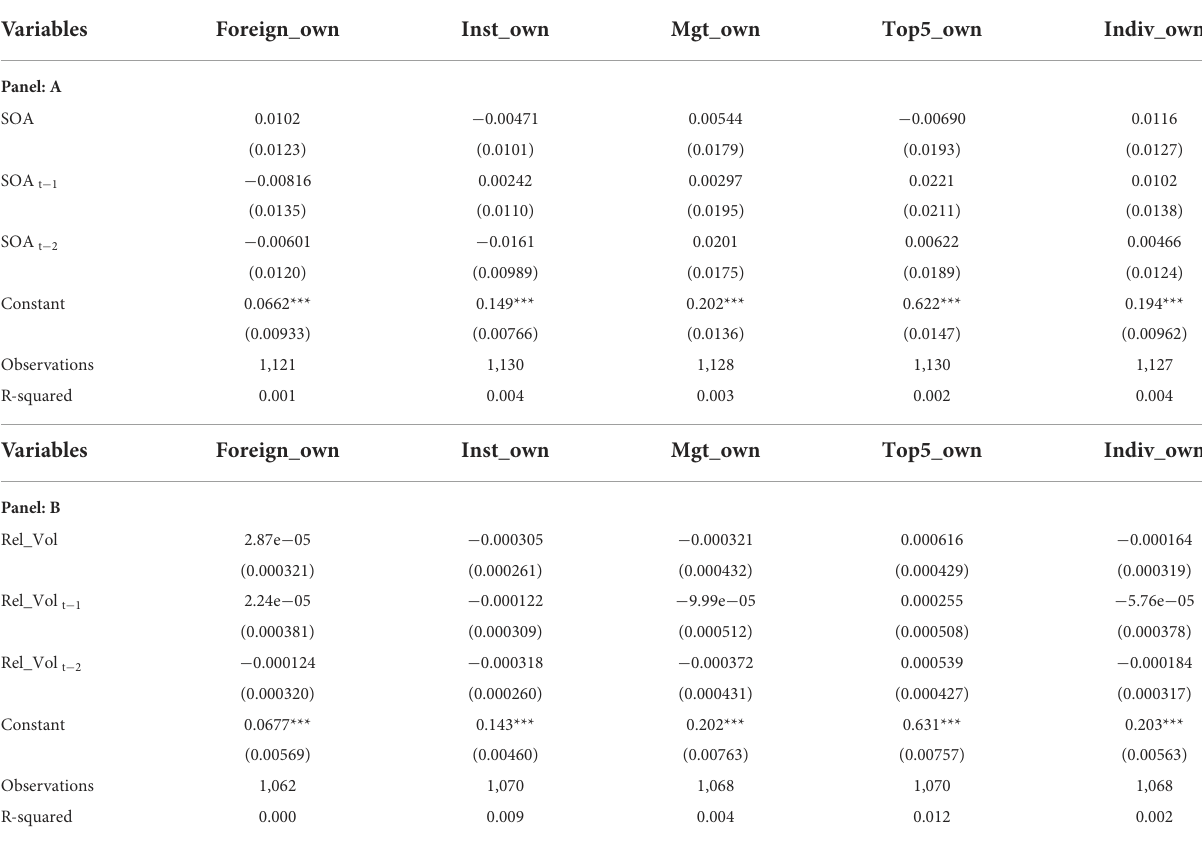
TABLE 11 Dividend smoothing and ownership